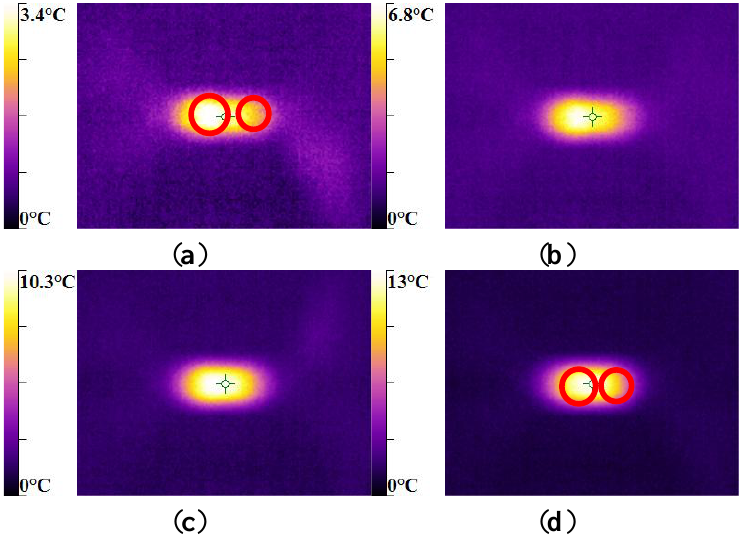
Figure 21. IR Thermographs of PMMA torsion test for V = 12 rad/min. ( a ) γ = 0.36 rad; ( b ) γ = 0.56 rad; ( c ) γ = 0.74 rad; and ( d ) γ = 0.94 rad.